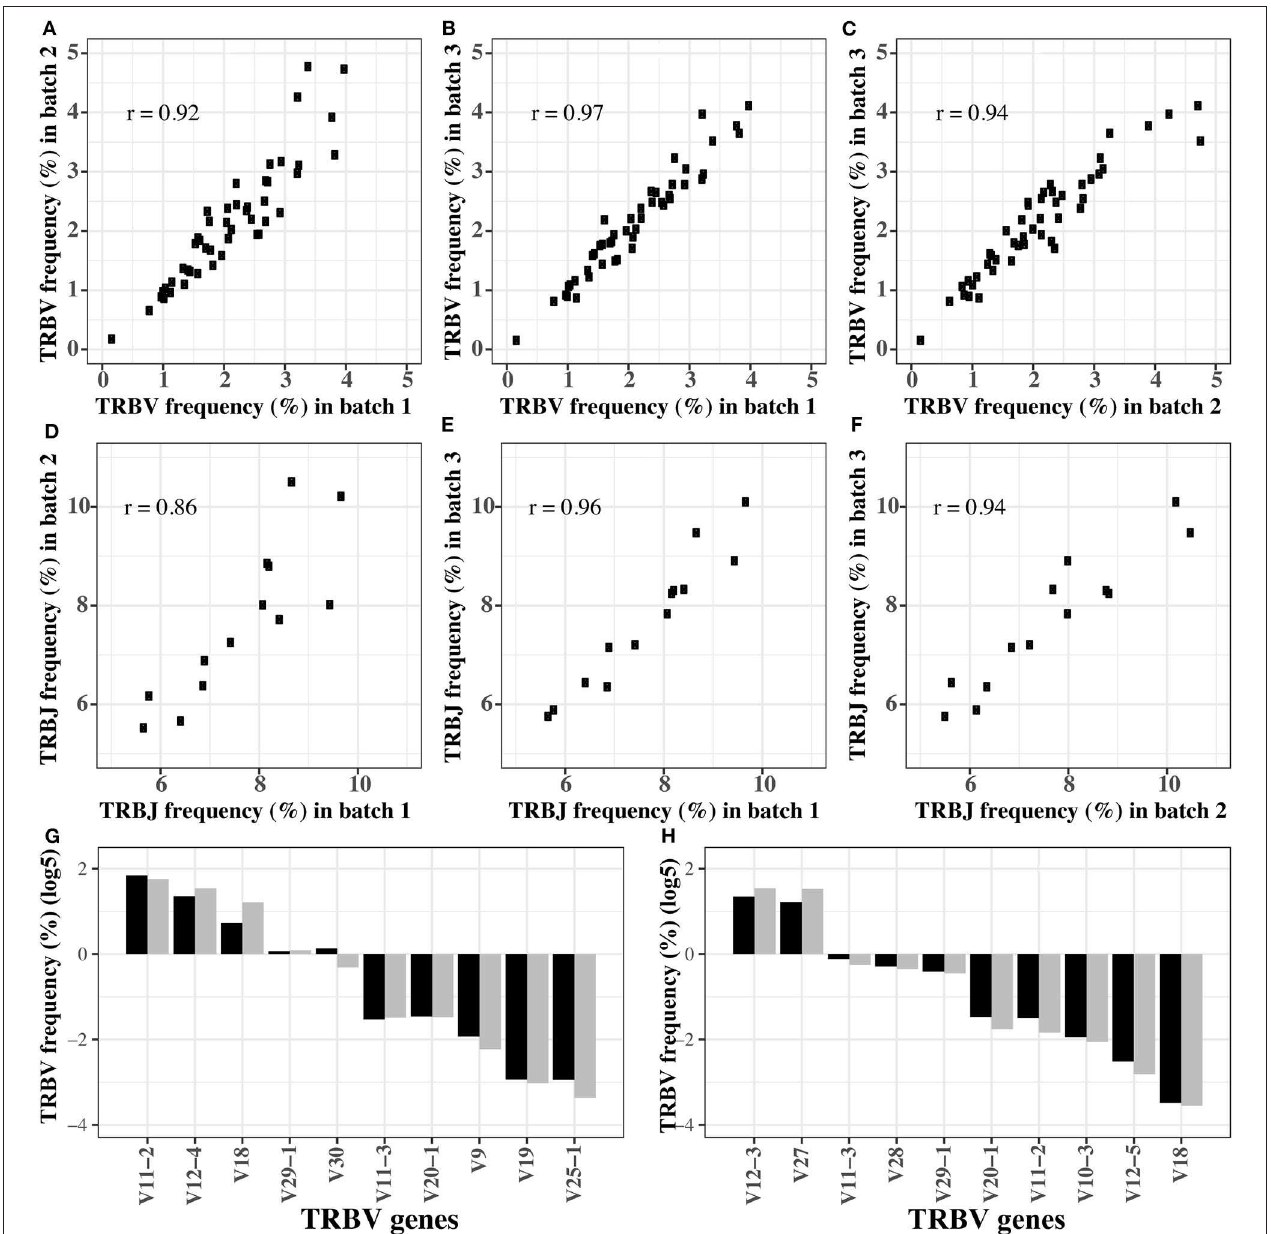
FIGURE 2 | The robustness of optimized multiplex PCR reaction system. (A–C) The TRBV usage frequency distributions in three batches of experiments. (D–F) The TRBJ usage frequency distributions in three batches of experiments. (G,H) The TRBV usage frequency before and after amplification for the first (G) and second (H) gradient mixture of the TRB templates. In (G,H) , the black bar is the TRBV usage before amplification, and gray bar is the TRBV usage after